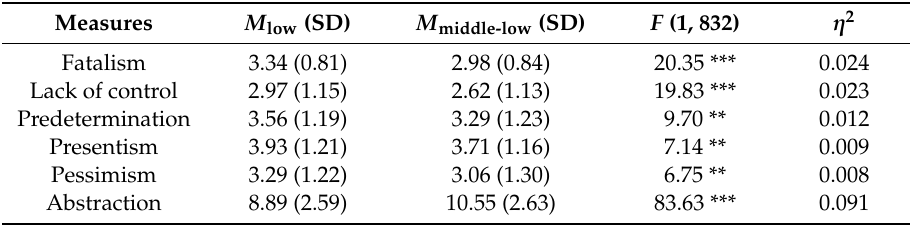
Table 2. Means for Low and Middle-low Status adolescents in Construal Level, Fatalism Score, and Fatalism’s Subscales.